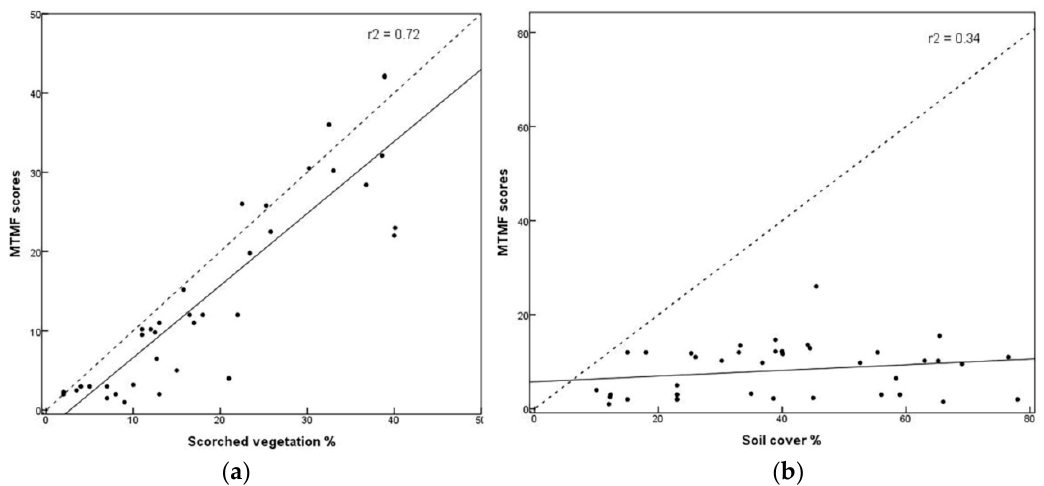
Figure 7. Scatterplots showing comparison of MTMF scores with ground data: ( a ) MTMF scores versus scorched vegetation cover in %, ( b ) MTMF scores versus soil cover in %.